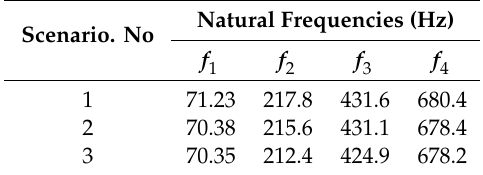
Figure 10. The stabilization diagram of the FBG 9. (black asterisk-frequency variation ratio [0–0.5%], Pink dot-frequency variation ratio [0.5–1%]): ( a ) The health; ( b ) the C2; ( c ) the C3. Table 5. The identified first four natural frequencies.